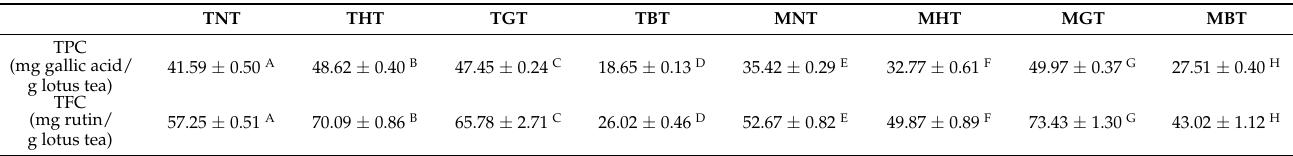
Table 1. Antioxidant contents of various lotus-leaf